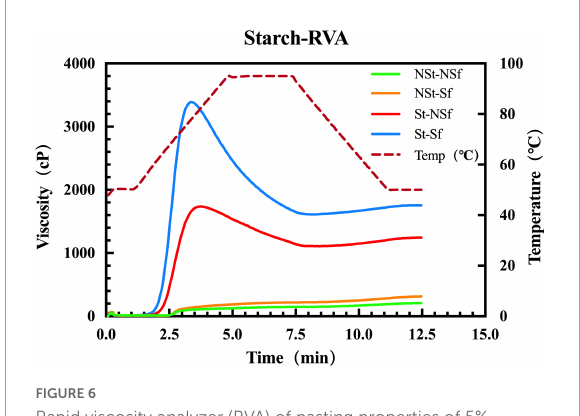
FIGURE6 Rapid viscosity analyzer (RVA) of pasting properties of 5% Gastrodia elata starch.